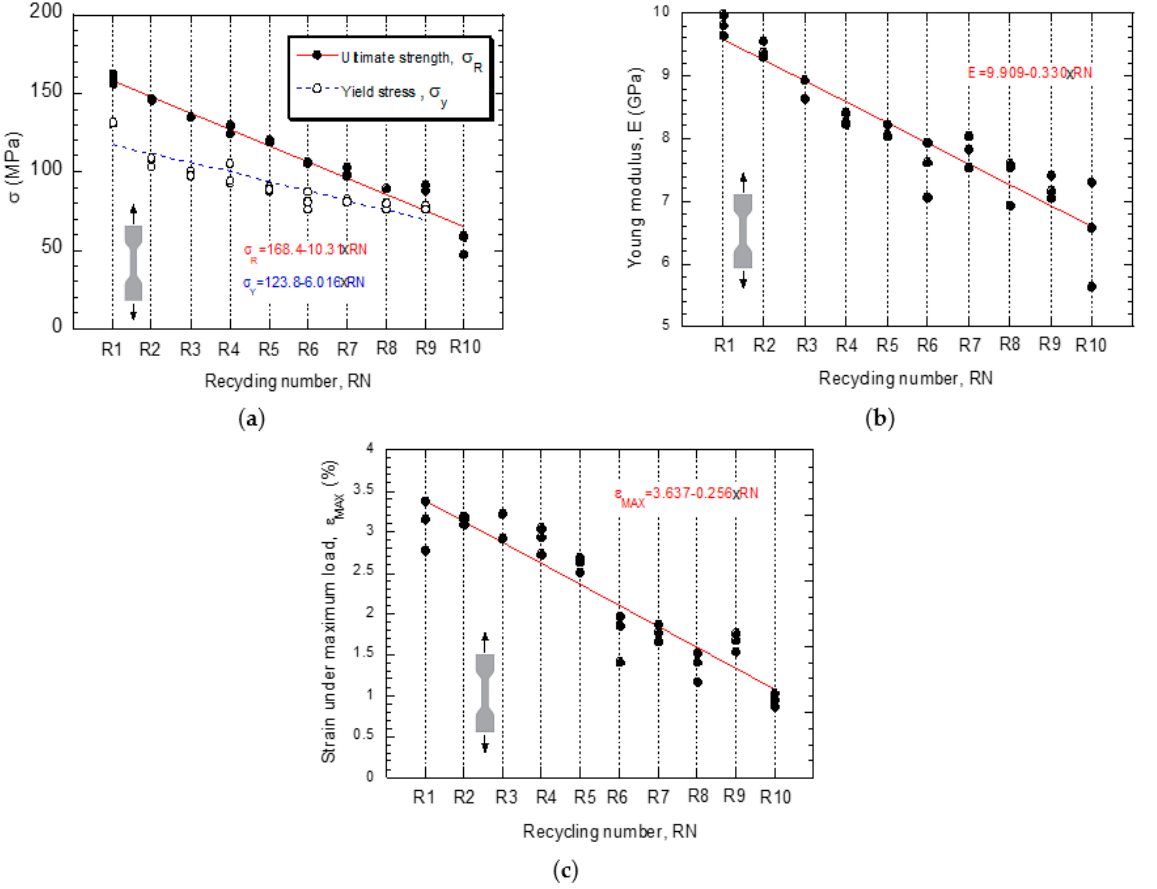
Figure 5. Change of mechanical properties as a function of the number of recyclings. ( a ) Yield stress, σ Y , and tensile strength, σ R , ( b ) Young’s modulus, E, evolution and ( c ) strain under maximum stress, ε MAX .